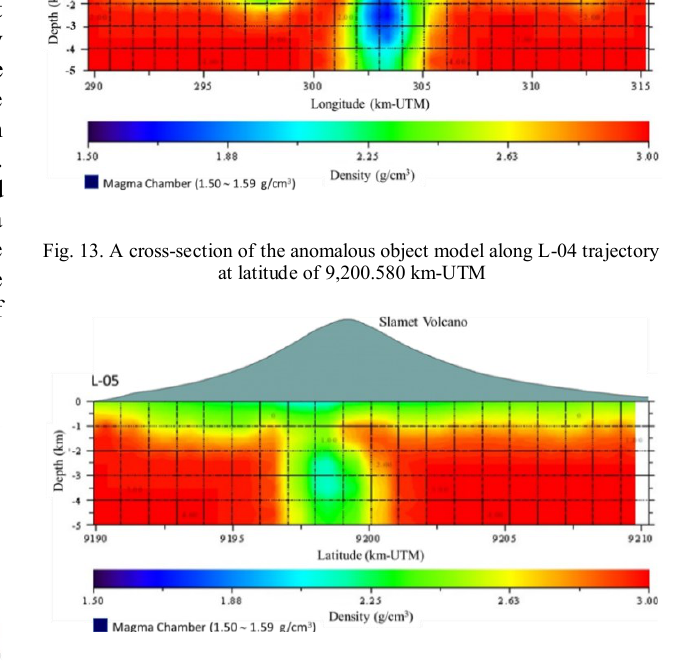
Fig. 14. A cross-section of the anomalous object model along L-05 trajectory at longitude of 301.470 km-UTM